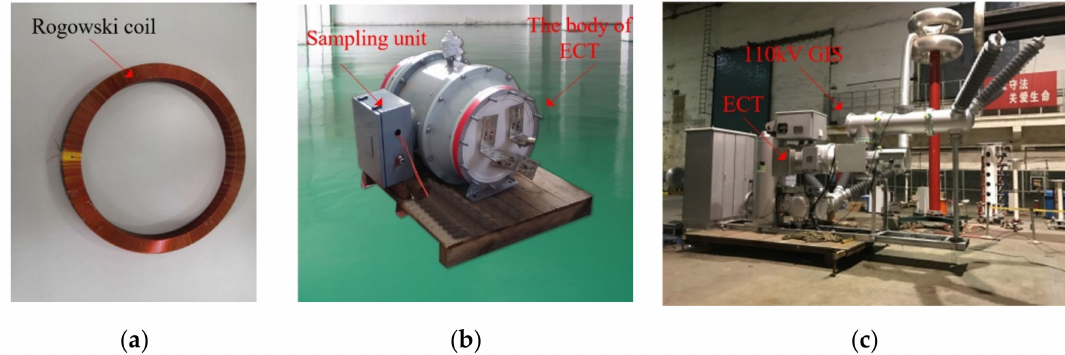
Figure 17. The GIS electronic current transformer developed in this paper: ( a ) Rogowski coil; ( b ) 110 kV ECT (no included merging unit); ( c ) ECT installed on 110 kV GIS.